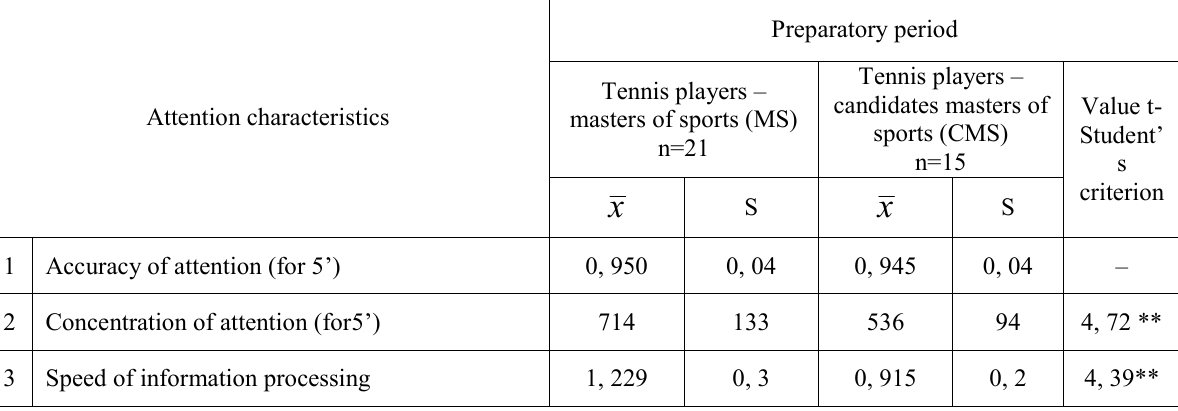
Indicators of attention characteristics of tennis players of different